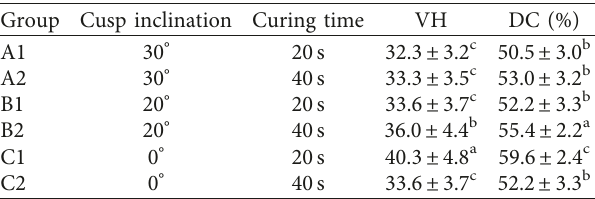
Different superscript letters in columns indicate the statistical difference ( p < 0 .